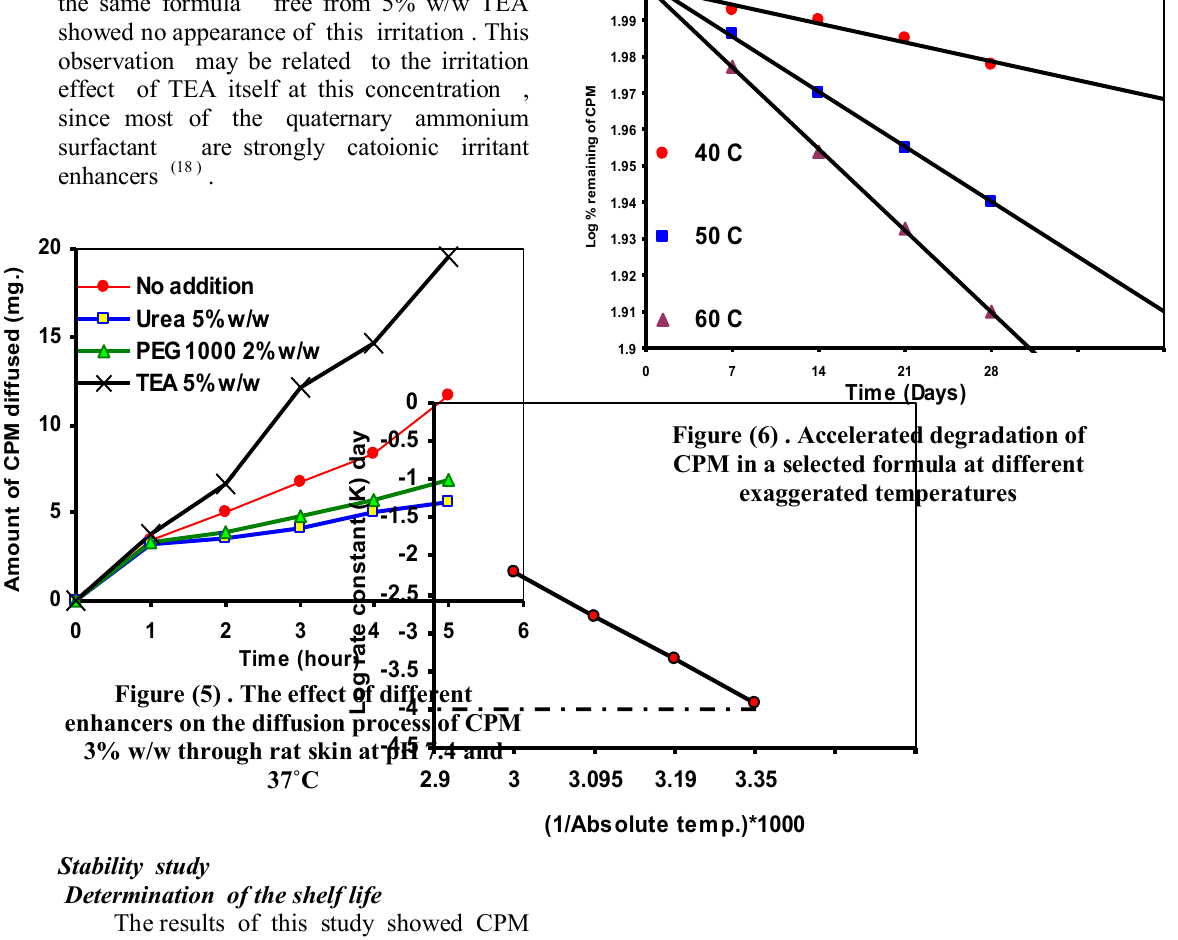
Figure 7 . Arrhenius plot for estimation of shelf life of CPM of a